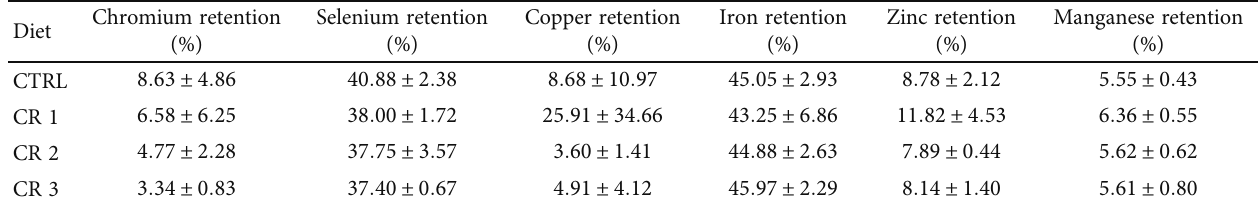
Table 8: Trace mineral retention of African cat fi sh after 84 days of feeding ( mean ± SD ).